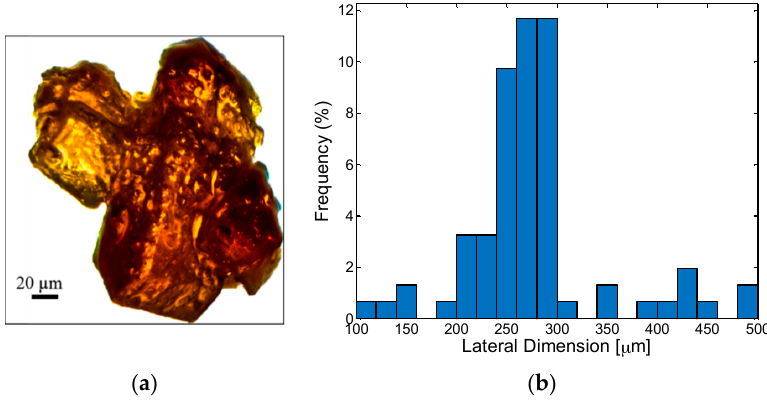
Figure 4. Optical image of a porogen ( a ); and porogen size distribution ( b ).